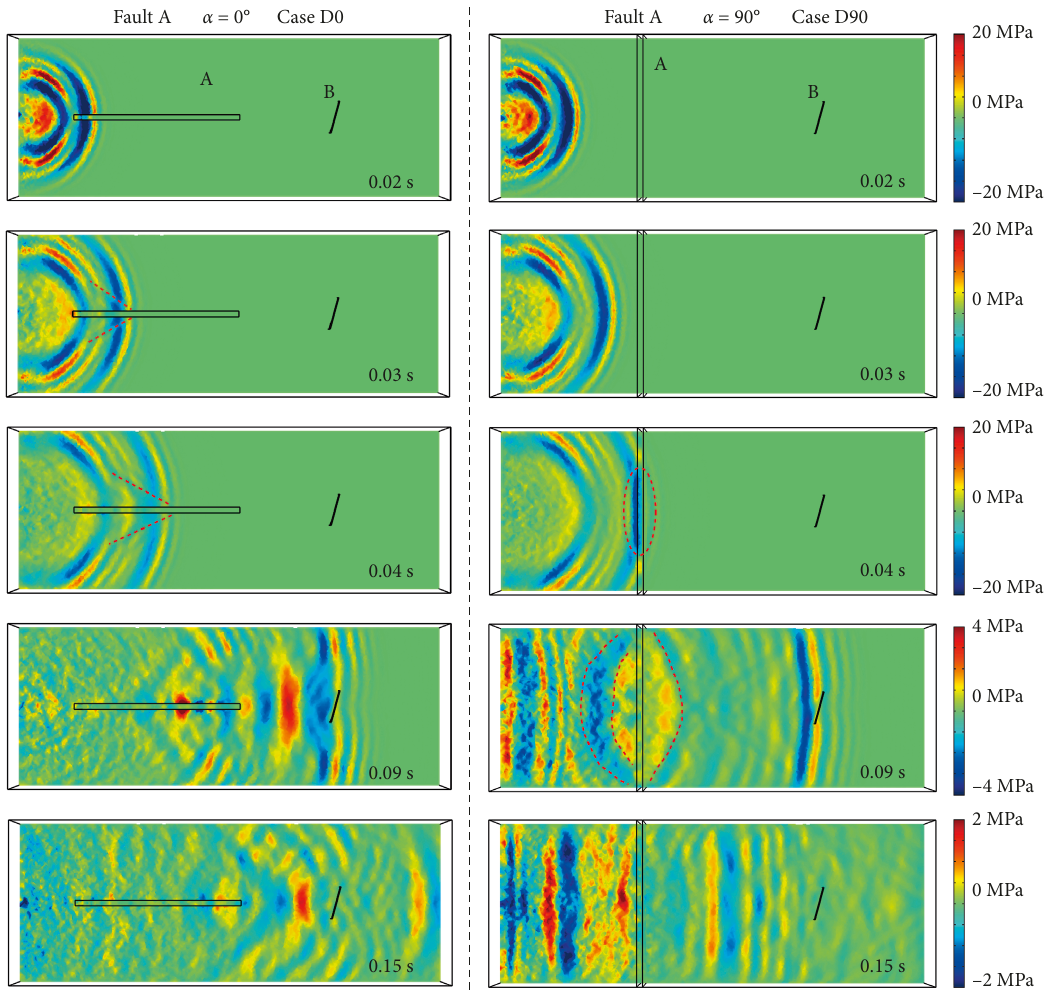
Figure 2: The cross section in the middle of the model box (Figure 1) showing the evolution and distribution of the stress in the XX direction when the dip angle ( α ) of fault A was set to 0 ° and 90 ° , respectively. The fault positions were indicated with black lines and purple front (A and